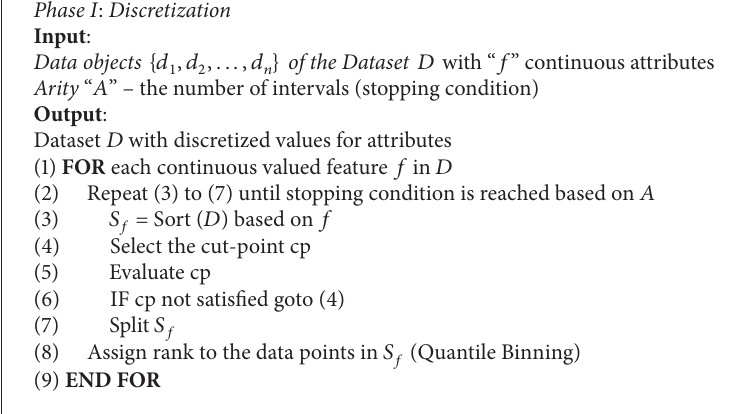
Algorithm 1: Steps in discretization.